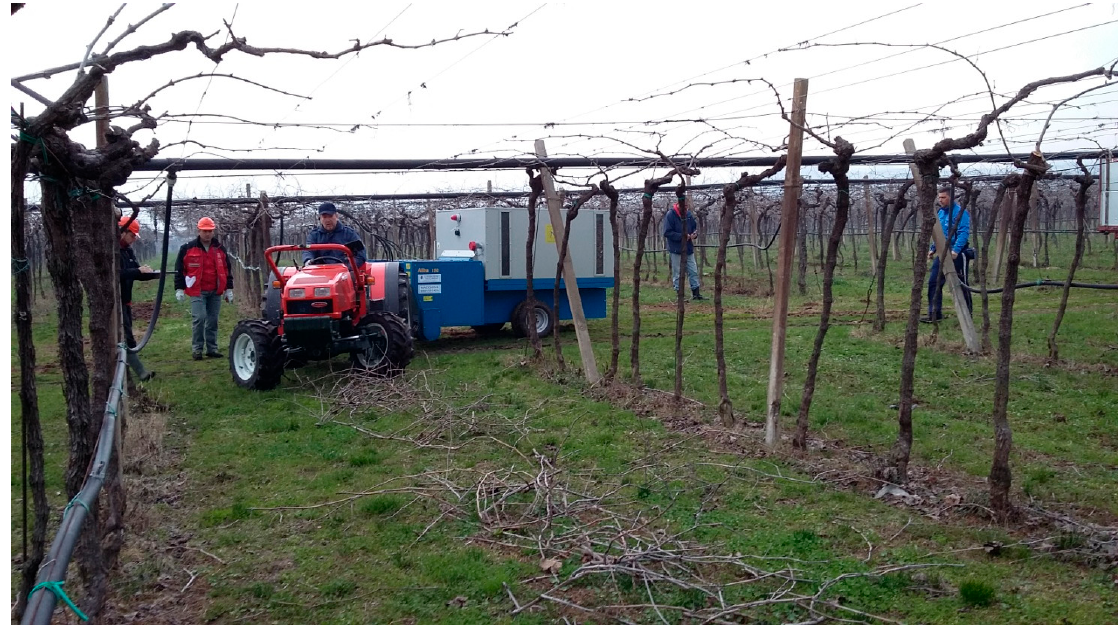
Figure 1. Pruning harvester manufactured by Costruzioni Nazzareno, MAREV Alba 150 model.